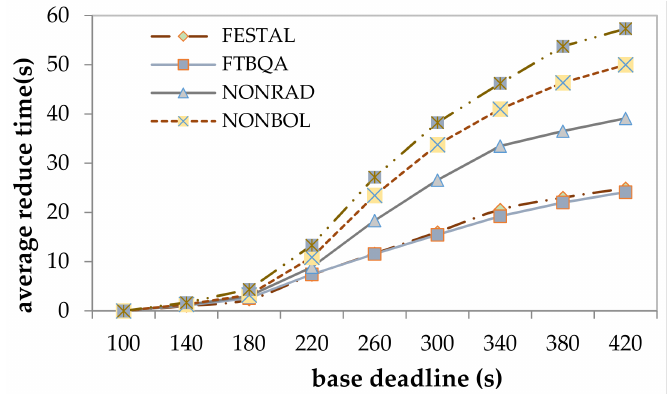
Figure 9. Average time reduction for a